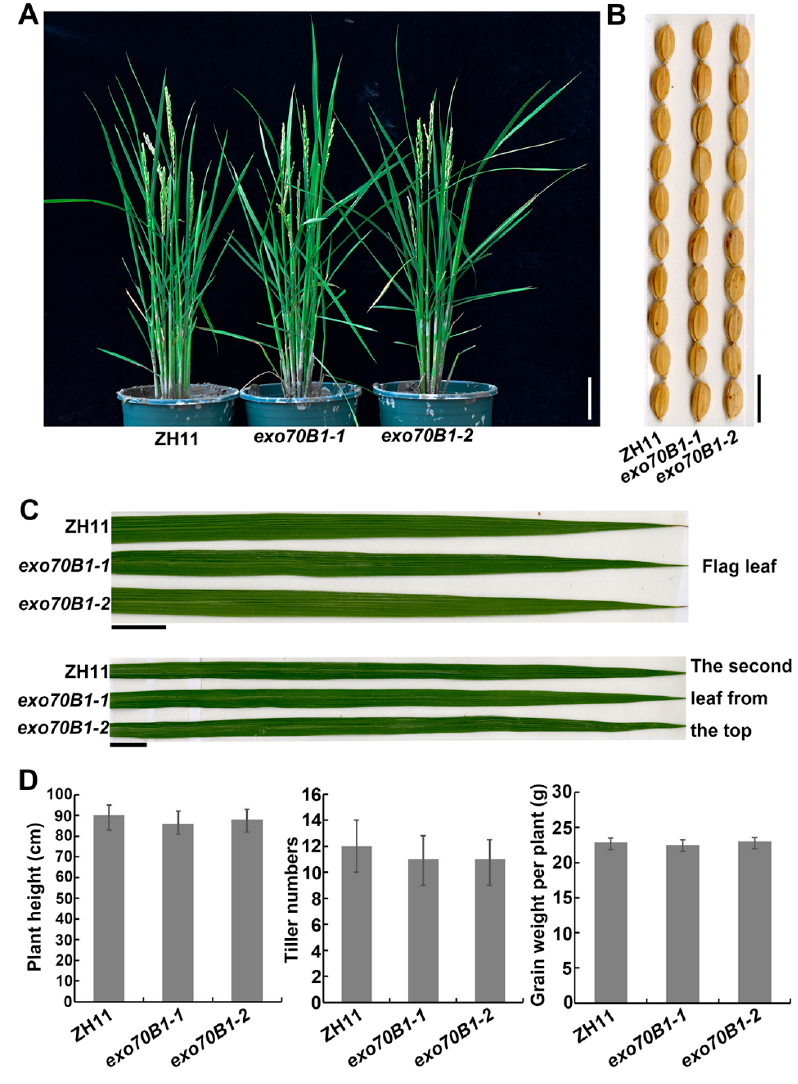
Figure 7. Growth and development phenotypes of the exo70B1-1 and exo70B1-2 mutants. ( A ) The plant architecture of ZH11, exo70B1-1 and exo70B1-2 at the heading stage. Bar = 15 cm. ( B ) Photograph of the seeds of ZH11, exo70B1-1 and exo70B1-2 . Bar = 1 cm. ( C ) Photograph of the flag leaf and top second leaf of the 4-week-old ZH11, exo70B1-1 and exo70B1-2 . Bar = 2 cm. ( D ) The plant height, tiller number and grain weight per plant of ZH11, exo70B1-1 and exo70B1-2 . Each bar represents the mean of twenty